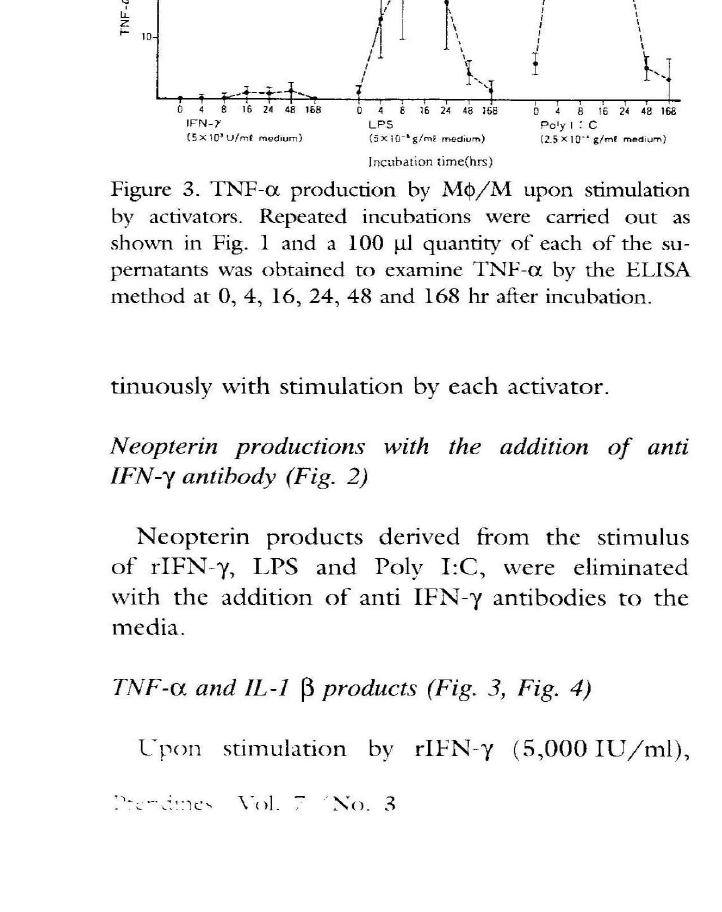
Stimulation by rIFN-y (1,000 IU/ml) alone fail ed to produce either TNF-Cf.. or IL-l ~ from M<jl/ M . However, after stimulation by LPS supplemen ted with rIFN-y (1,000 IU/ml), a multiplicative ef fect on the amount of the products of TNF-Cf.., IL-l [3 and neopterin released from M<jl/M were